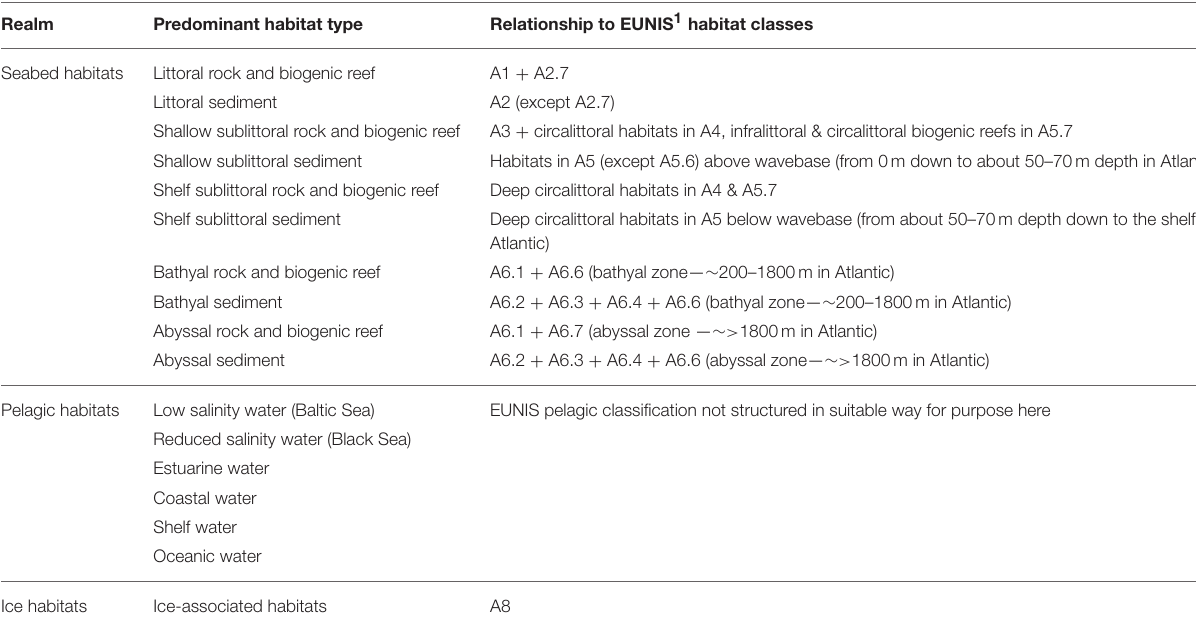
TABLE 3 | Predominant habitat types for application in assessment of Descriptor 1.